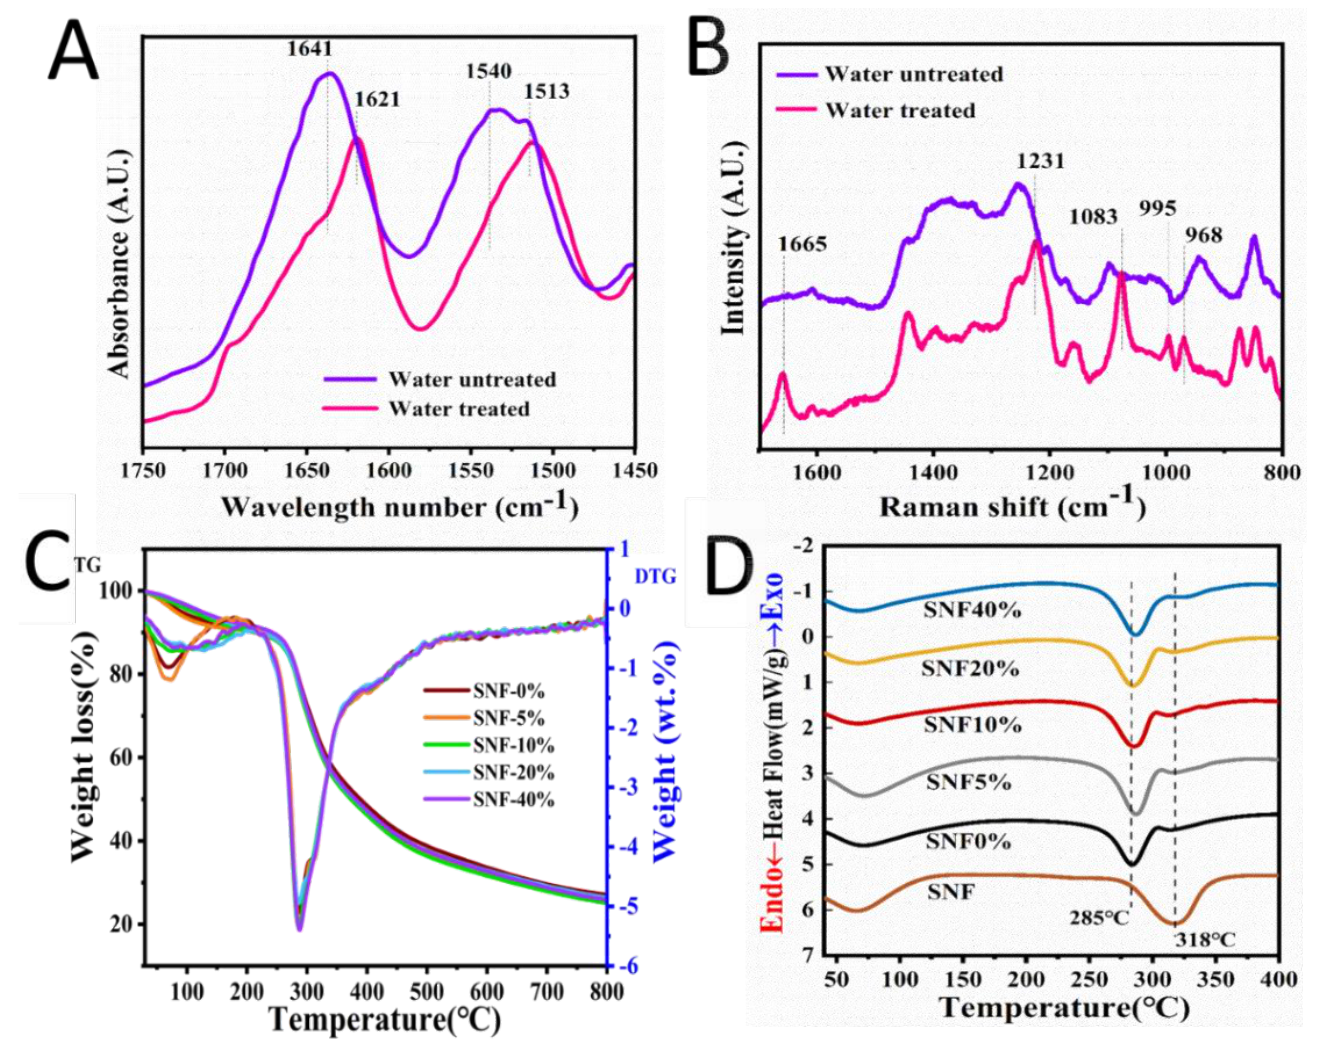
Figure 6. Structure analysis and thermal stability of the silk rod derived from the Ca 2+ -FA system. ( A ) represents ATR-FTIR and ( B ) Raman spectra of the silk hydrogel derived from Ca 2+ -FA system treated and untreated by water ( C ), represents TG-DTG of dried silk rod with different SNF, and ( D ) represents DSC of dried silk rod with different SNF.